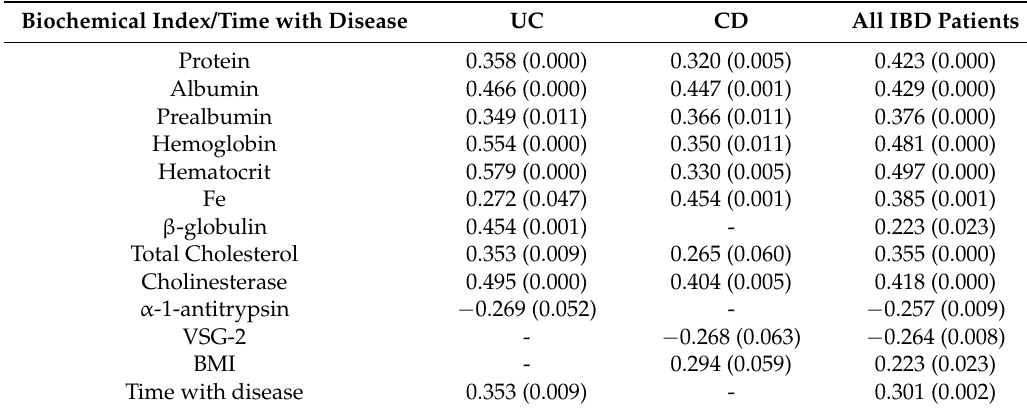
Table 10. Correlation analysis results showing significant and borderline significant differences in serum Se concentrations as a function of biochemical index/time with